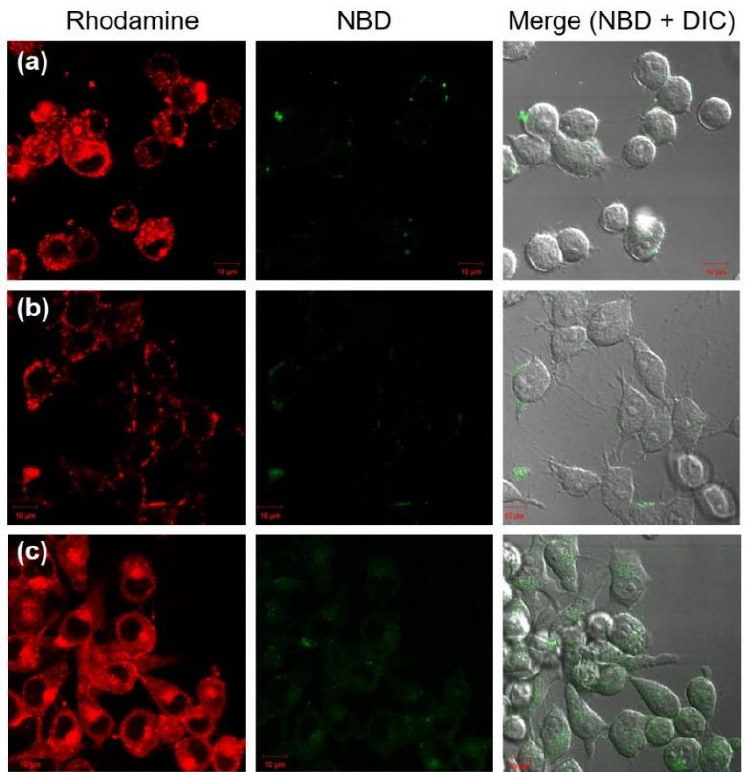
Figure 4. Confocal laser scanning microscopic (CLSM) images of DC2.4 cells treated with DLPC liposomes ( a ), EYPC/deoxycholic acid micelles ( b ) and DLPC/deoxycholic acid micelles ( c ) for 5 h. Fluorescence of NBD-PE and Rh-PE upon excitation at 488 nm was observed using a CLSM. Scale bar represents 10 μm.